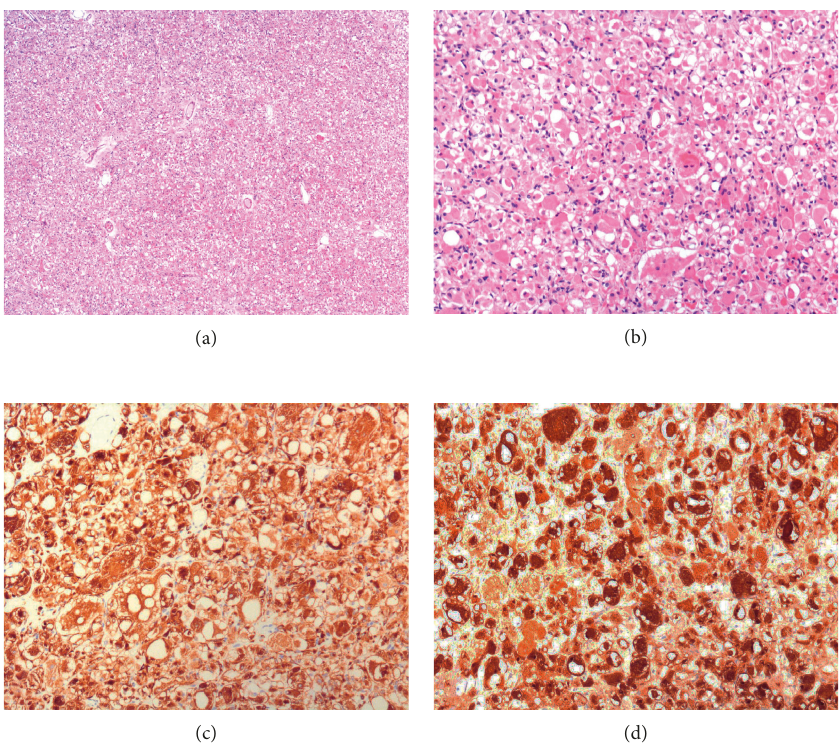
Figure 2: (a) Low- and (b) high-power magnification of tumor sections stained with haematoxylin and eosin. The neoplastic cells are diffusely positive for (c) desmin and (d)